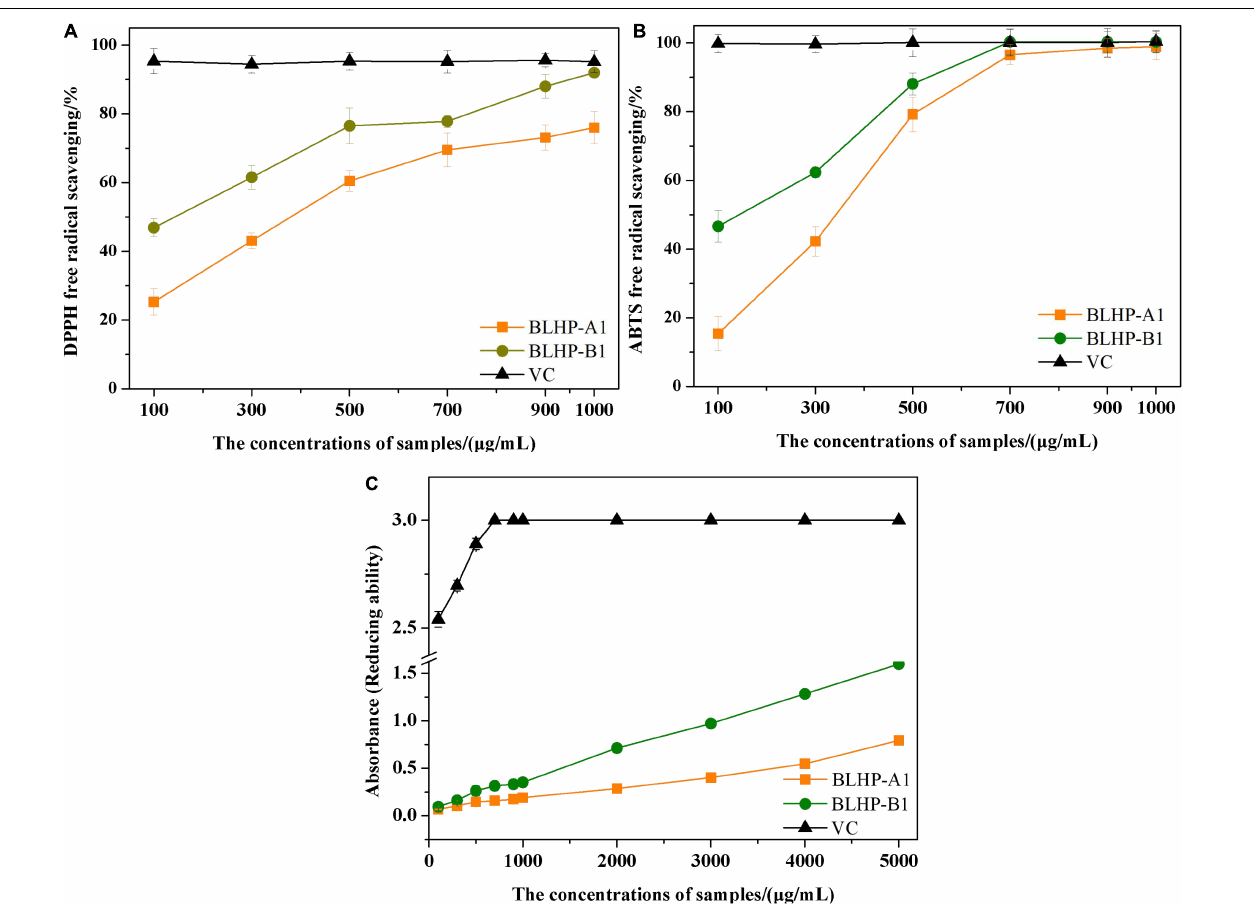
FIGURE 6 | The measurements of antioxidant activities of BLHP-A1 and BLHP-B1 in chemical view, compared with relevant abilities of VC. (A) DPPH · radicals scavenging of BLHP-A1 and BLHP-B1 samples in the concentration range of 100–1,000 µ g/ml. (B) ABTS + radicals scavenging of BLHP-A1 and BLHP-B1 samples in the concentration range of 0.1–1.0 mg/ml. (C) Reducing ability of BLHP-A1 and BLHP-B1 samples. The absorbances were recorded at 700 nm.